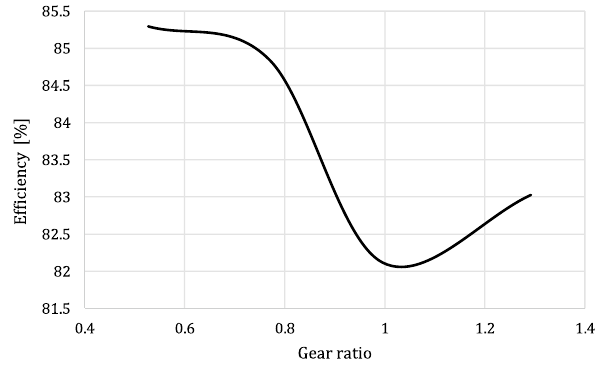
Fig. 13 Efficiency of the transmission composed by the double chain and the internal shift as a function of the gear ratio